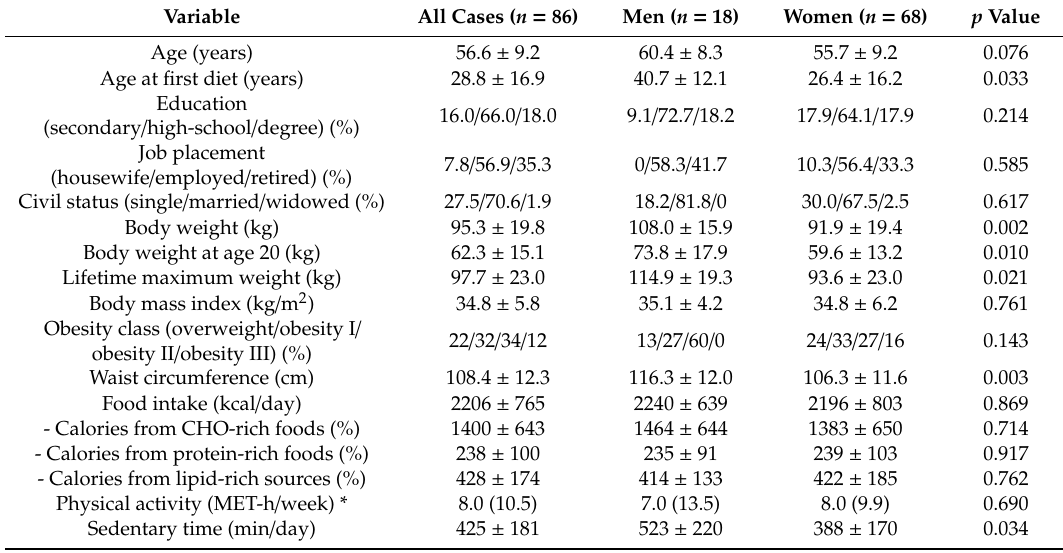
Table 1. Sociodemographic, clinical and behavioral characteristics of patients enrolled in the study. Variable All Cases ( n =